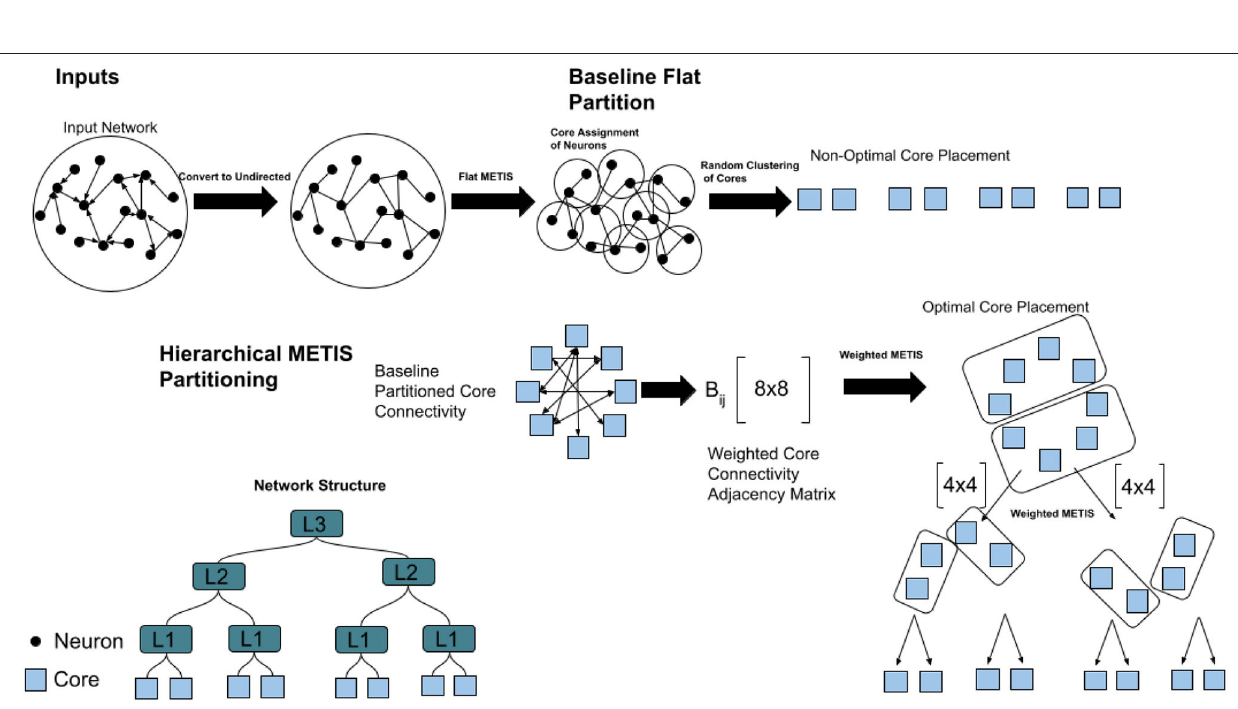
FIGURE 3 | Hierarchical network partitioning algorithm and baseline flat partitioning